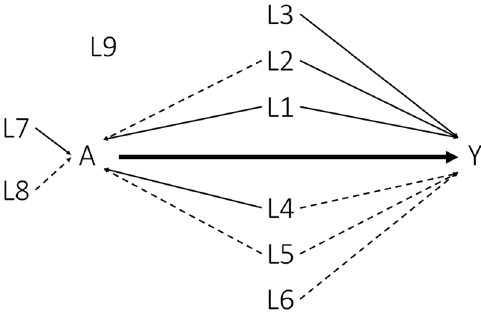
Figure 1. Causal diagram. Solid lines corresponded to a strong association (OR = 6.0) and dashed lines to a moderate one (OR =